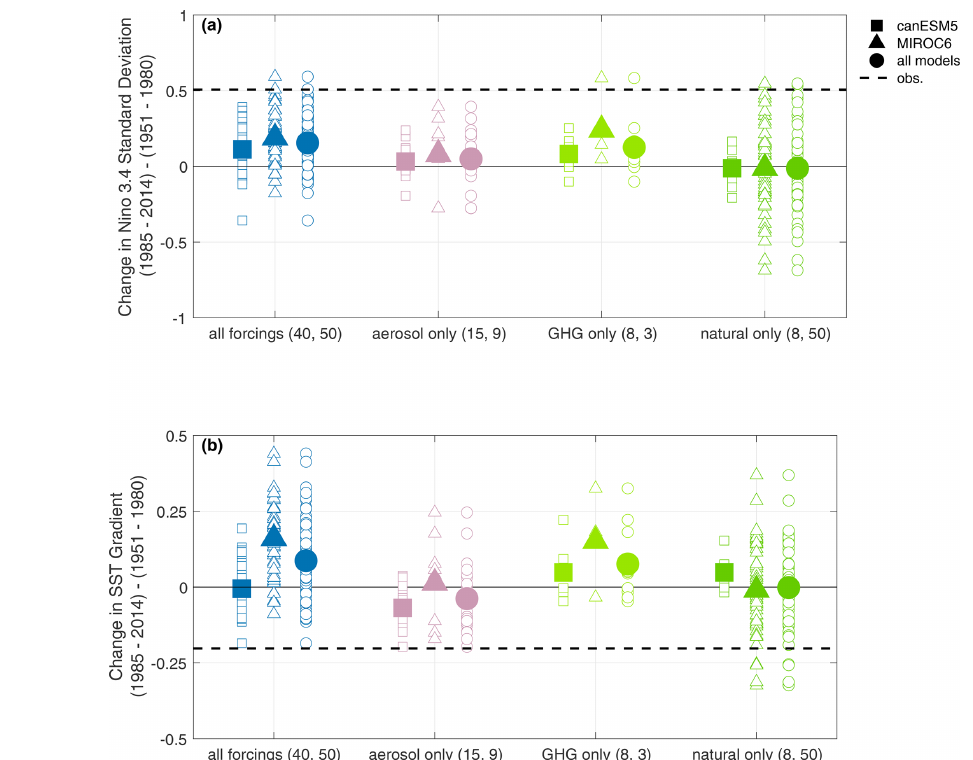
Figure 10. Change in the Niño 3.4 index standard deviation and tropical Pacific SST gradient in DJF in the two available single-forcing ensembles. (a) Change in the Niño3.4 index standard deviation over the second half of the 20th century (1985–2014 minus 1951–1980). Individual ensemble members from CanESM5 (squares), MIROC6 (triangles), and the combination of the two ensembles (circles) are shown with open symbols. The average change is shown with a filled marker. Observed changes (ERSSTv5) are shown by the dashed black line. (b) Change in the tropical Pacific SST gradient (the difference in SST between the eastern and western equatorial Pacific; defined as in Fig. 7; x axis) over the same time period. We use the same visual conventions. Note that the sum of individual forcings may not add up to the “all forcings” scenario, particularly in relatively small